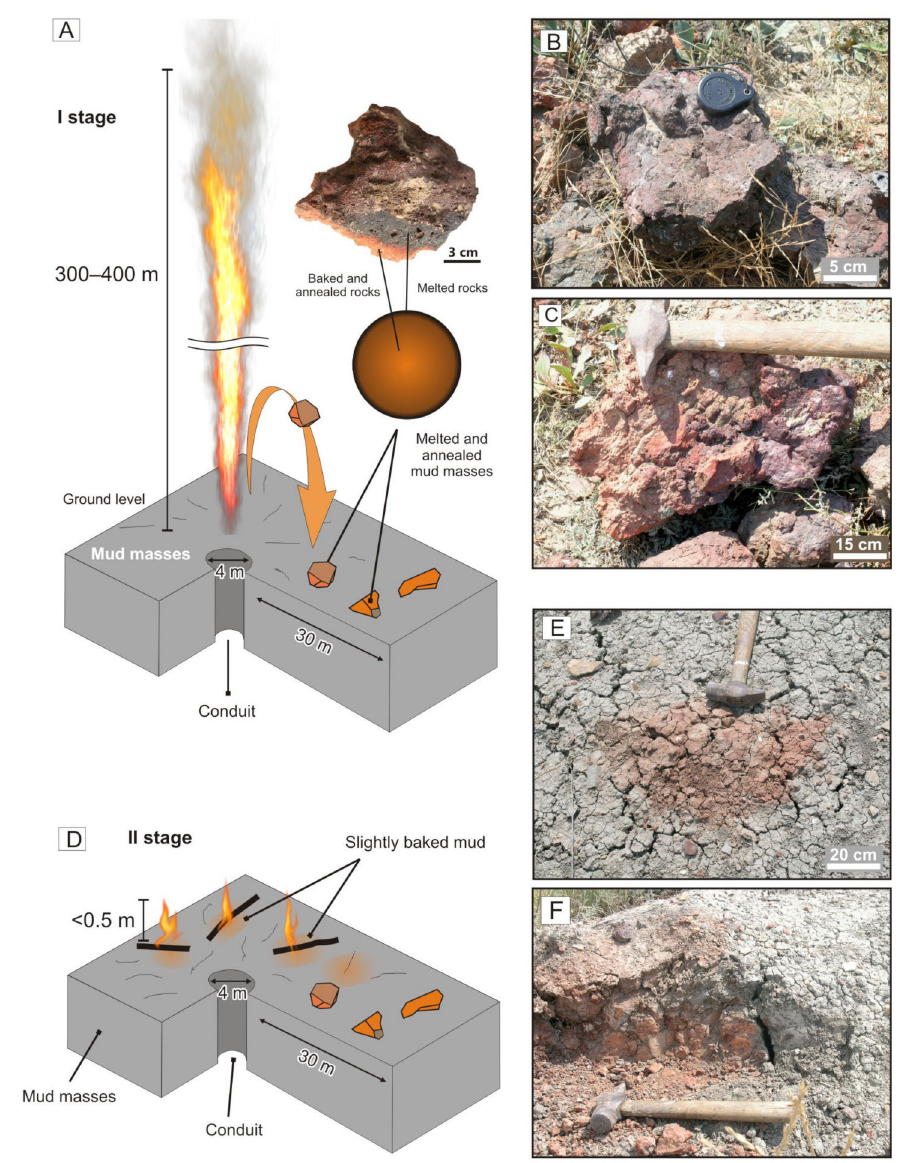
Figure 3. Model of Karabetova Gora MV fire eruption of 6 May 2000 and distribution of CM rocks. ( A , D ) Fire history. Color codes are: gray for unaltered mud; orange for slightly annealed mud and clinker (color intensity is proportional to degree of CM alteration); brown and black for paralava. ( B , C ) Blocks of clinker and paralava formed upon direct contact with flame (Stage I). ( E ) Reddish thermally altered rocks around the foci of burning venting gas (Stage II). ( F ) Reddish annealed mud in heavily fractured mud cover (Stage